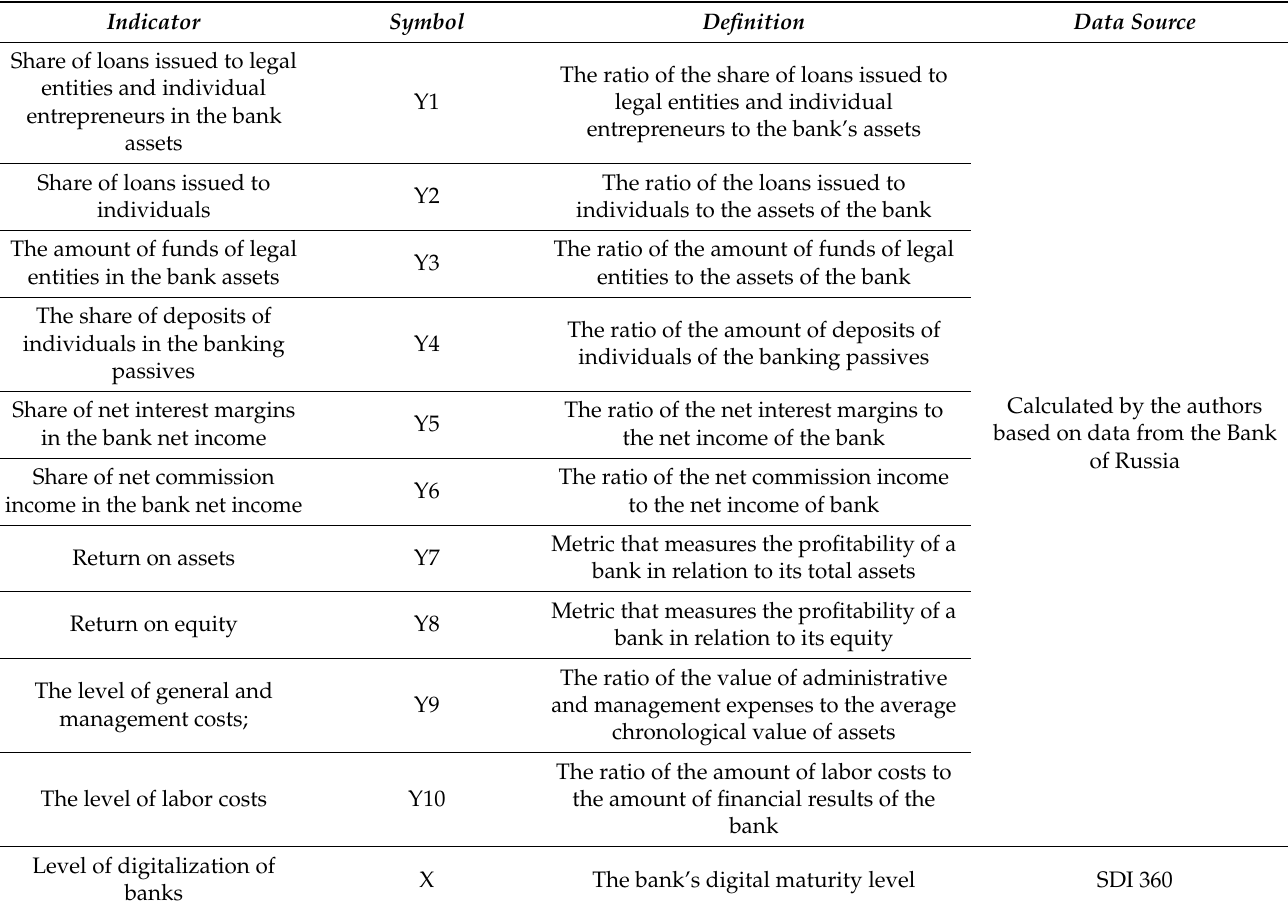
Table 1. Description of variables and data